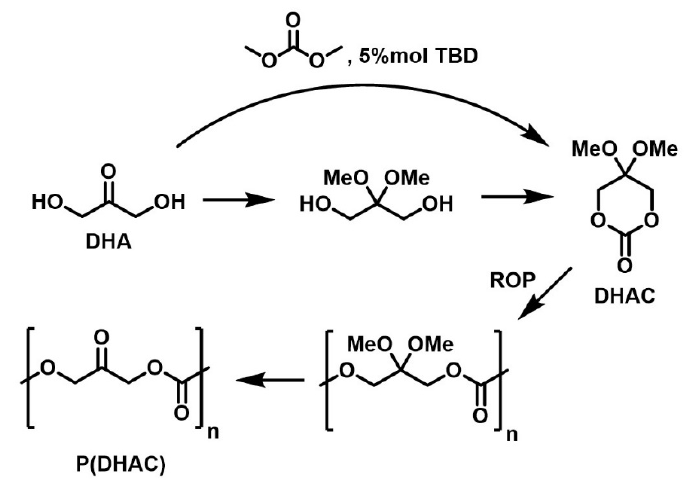
Figure 15. Routes to DHAC synthesis and polymerization to